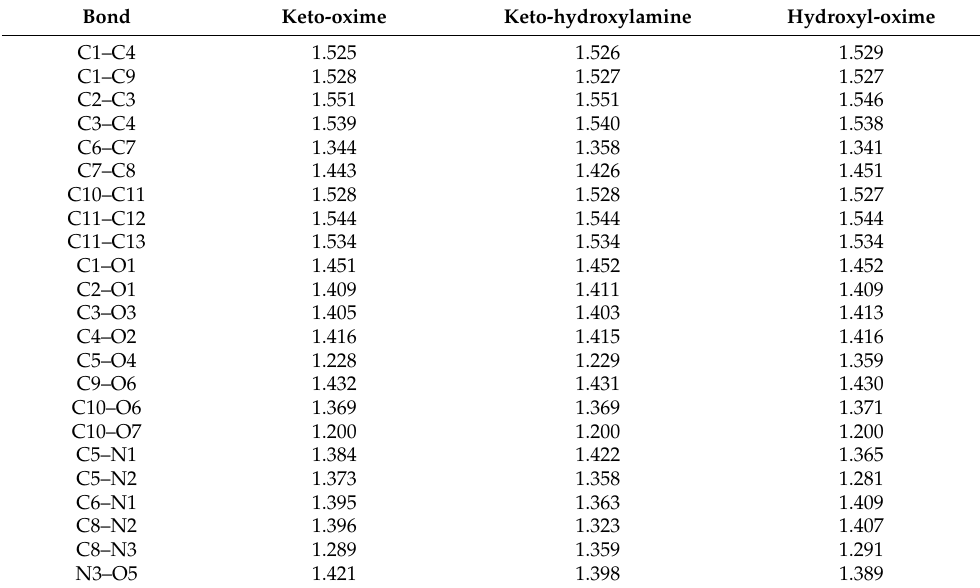
Table 2. Selected bond lengths (Å) in the optimized structures of the keto-oxime, keto-hydroxylamine, and hydroxyl-oxime tautomers of molnupiravir, obtained by using the DFT/B3LYP/6-311++G(d,p) method.